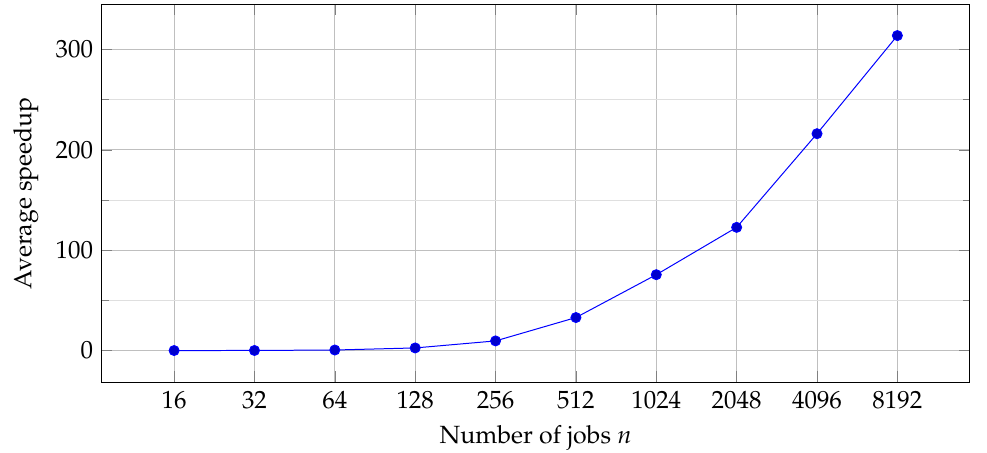
Figure 6. Speedup of the parallel algorithm executed on GPU, in relation to the sequential algorithm executed on a single CPU